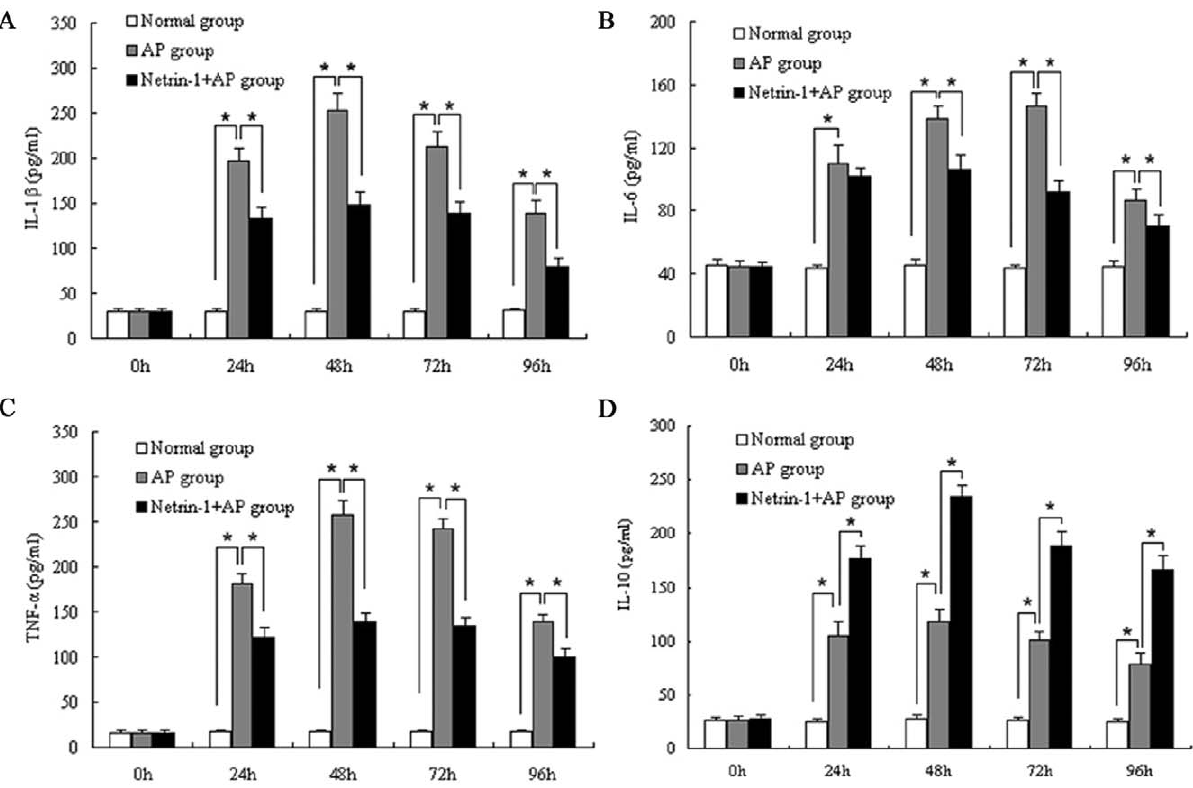
Figure 4. Effect of Netrin-1 on plasma cytokines level. IL-1 b , IL-6, TNF- a , and IL-10 plasma concentrations at the indicated times are shown for the normal group and AP groups with and without netrin-1 treatment. Acute pancreatitis was induced by two intraperitoneal injections of L-Arginine (4 g/kg, 1 h apart). Mice were treated with recombinant mouse netrin-1 at a dose of 1 m g/mouse or vehicle (0.1% BSA) immediately after the second injection of L-Arginine and every 24 h thereafter. Data are presented as mean 6 SD (n=6 per group in the normal mice, n=8 per group both in the AP model and netrin-1 treated AP model). * P , 0.05.